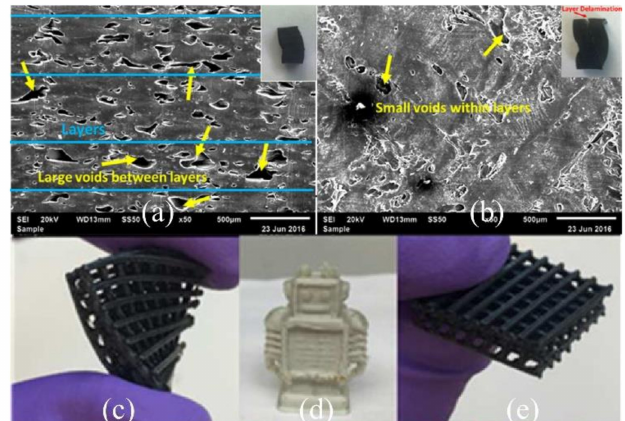
Figure 6. ( a ) SEM image of cross-section of S specimen (0.5 wt.%) (inset shows image of specimen after S compression testing). ( b ) SEM image of cross-section of L specimen (0.5 wt.%) (inset shows image of specimen after L compression testing). ( c ) 3D-printed micro-lattice under bending (5 wt.% of graphene oxide (GO)). ( d ) 3D-printed Ultimaker robot (0 wt.% of GO). ( e ) 3D-printed micro- lattice (5 wt.% of GO) (Reproduced with permission from Reference [88], copyright 2017, American Chemical